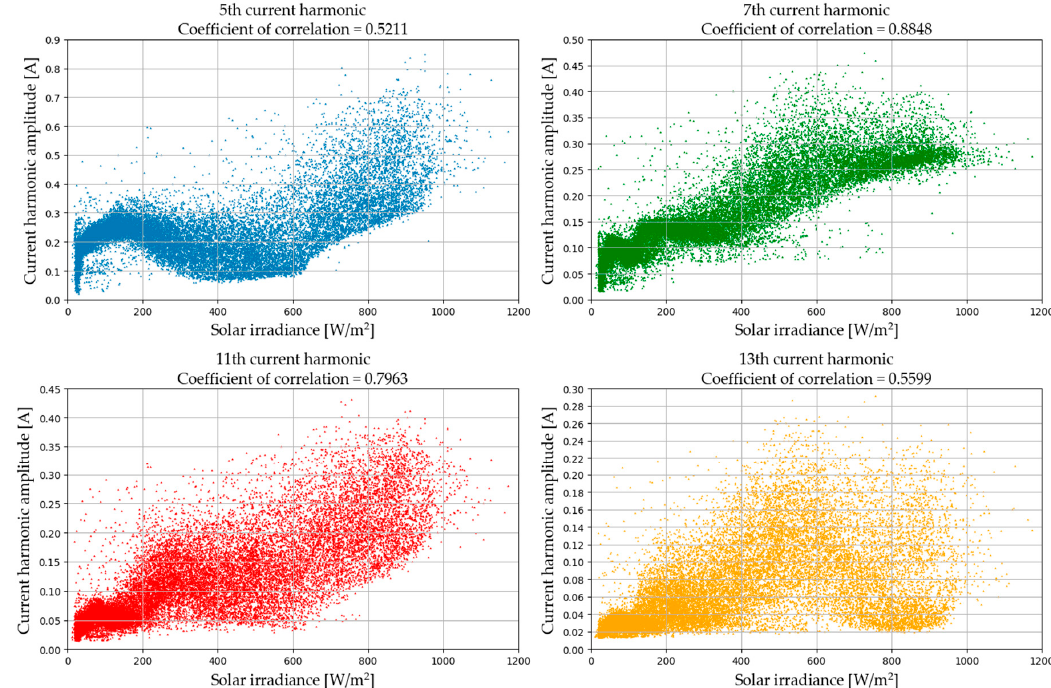
Figure 8. 5th, 7th, 11th, and 13th current harmonic amplitudes in relation to solar irradiance.